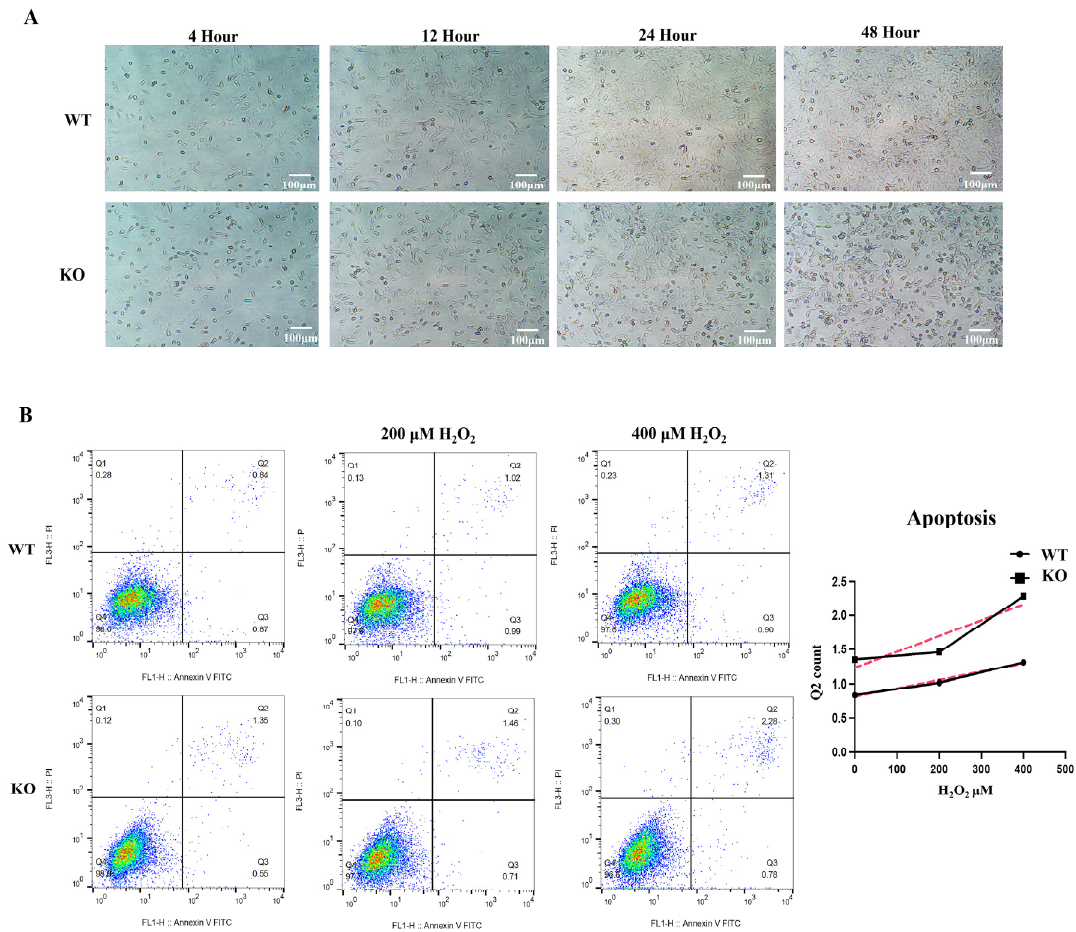
Figure 6. Raised index of late apoptosis in KO cells. ( A ) KO cell proliferation is accompanied by increased production of dead cells. In total, a 5 × 10 5 amount of cells were cultivated in 33 °C 10% CO 2 in 6-well plates and observed and photographed every 12 h under a phase-contrast microscope for 2 days. ( B ) Apoptosis was detected by flow cytometry. The number of positive cells in the Q2 quadrant, representing the late stage of apoptosis, was counted to plot the line graph. Cells were cultured under 0, 200, and 400 µ M H 2 O 2 for 3 h before the test. The red dotted line represents the